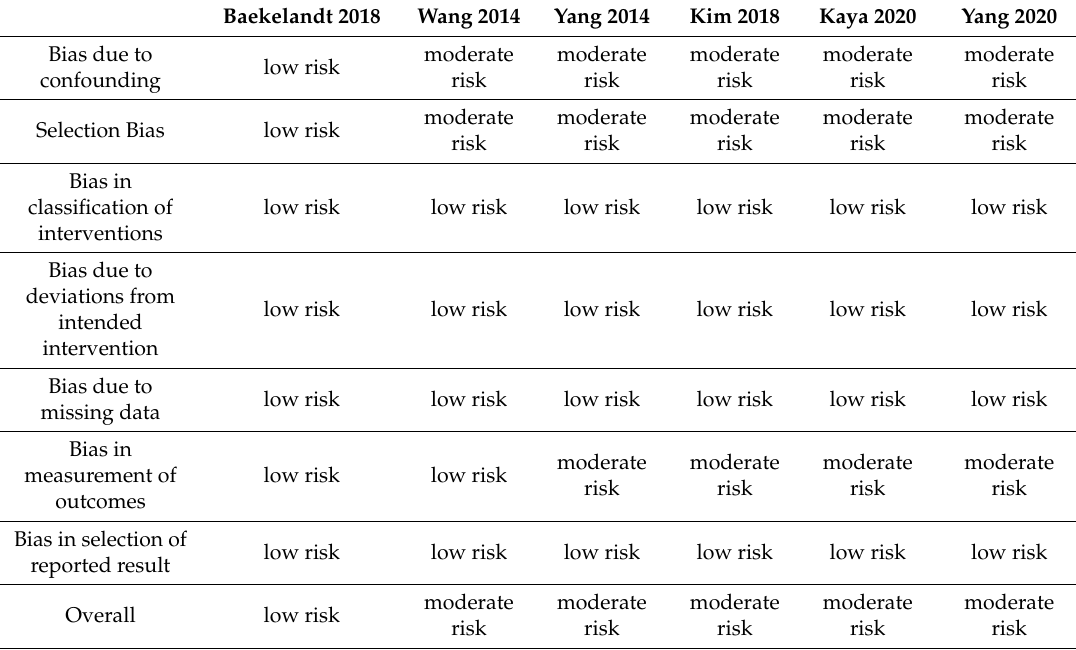
Table 2. Simplified summary of the risk of bias